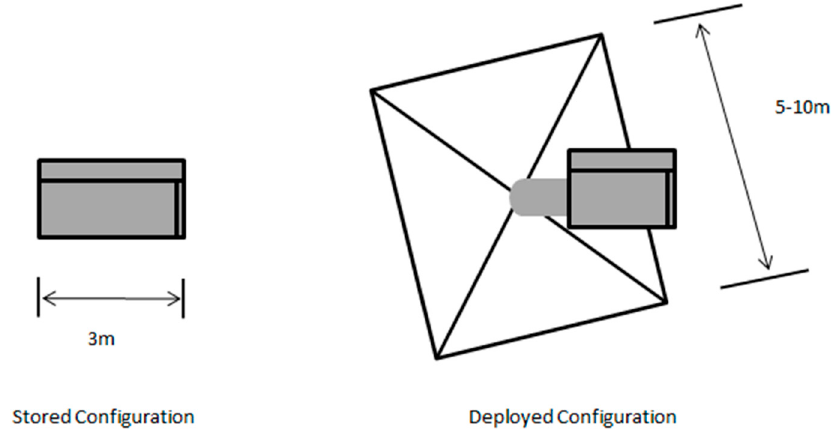
Figure 24. Stowed vs. Deployed Solar Sail Configuration [40].